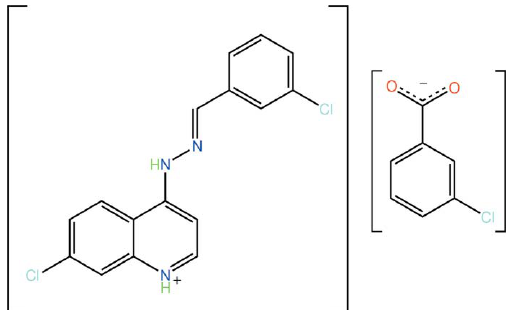
Nonius KappaCCD area-detector diffractometer